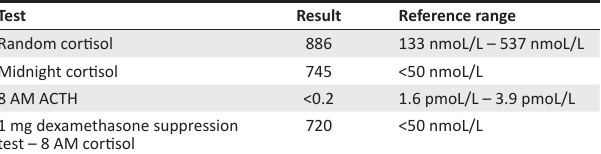
TABLE 1: Biochemical investigations.